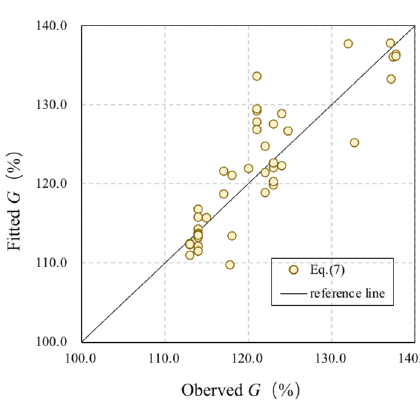
Figure 3. Comparison between observed and fitted G values based on Eq.